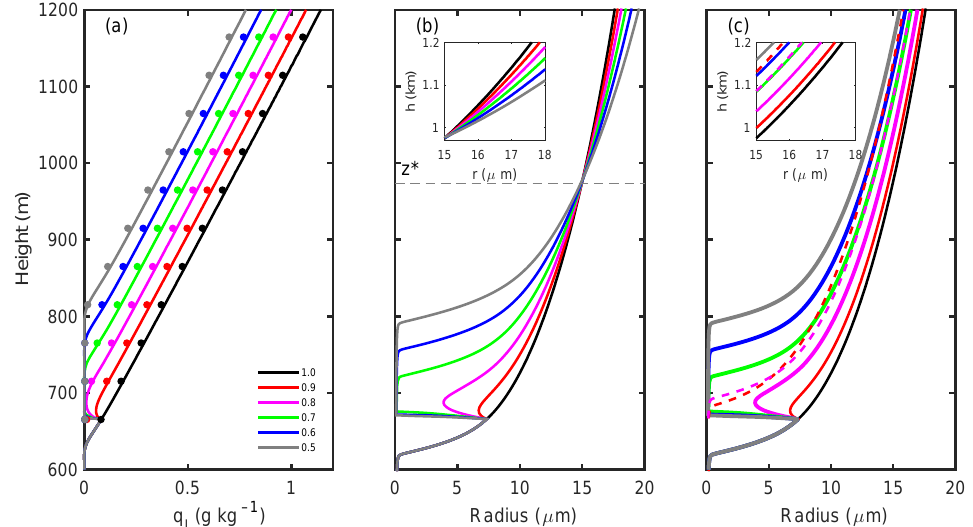
Figure 2. (a) Liquid water mixing ratio profiles for various cloud mixing fractions χ and with high updraft speed (1 . 0ms − 1 ). Lines are from the parcel model and dots are from the theoretical prediction given by Eq. (17). (b) Cloud droplet radius vs. height for various χ when mixing with clean (aerosol-free) environmental air. The horizontal dashed line represents the critical height z ∗ calculated from Eq. (20). (c) Cloud droplet radius vs. height for various χ when mixing with polluted environmental air (air containing CCN similar to cloud base conditions). Insets in panels (b) and (c) show details of the radius profiles above the critical height. Super-adiabatic droplet growth, i.e., droplet diameters greater than in the unmixed cloud ( χ = 1 . 0), is observed for all χ in panel (b) but for none in panel (c)